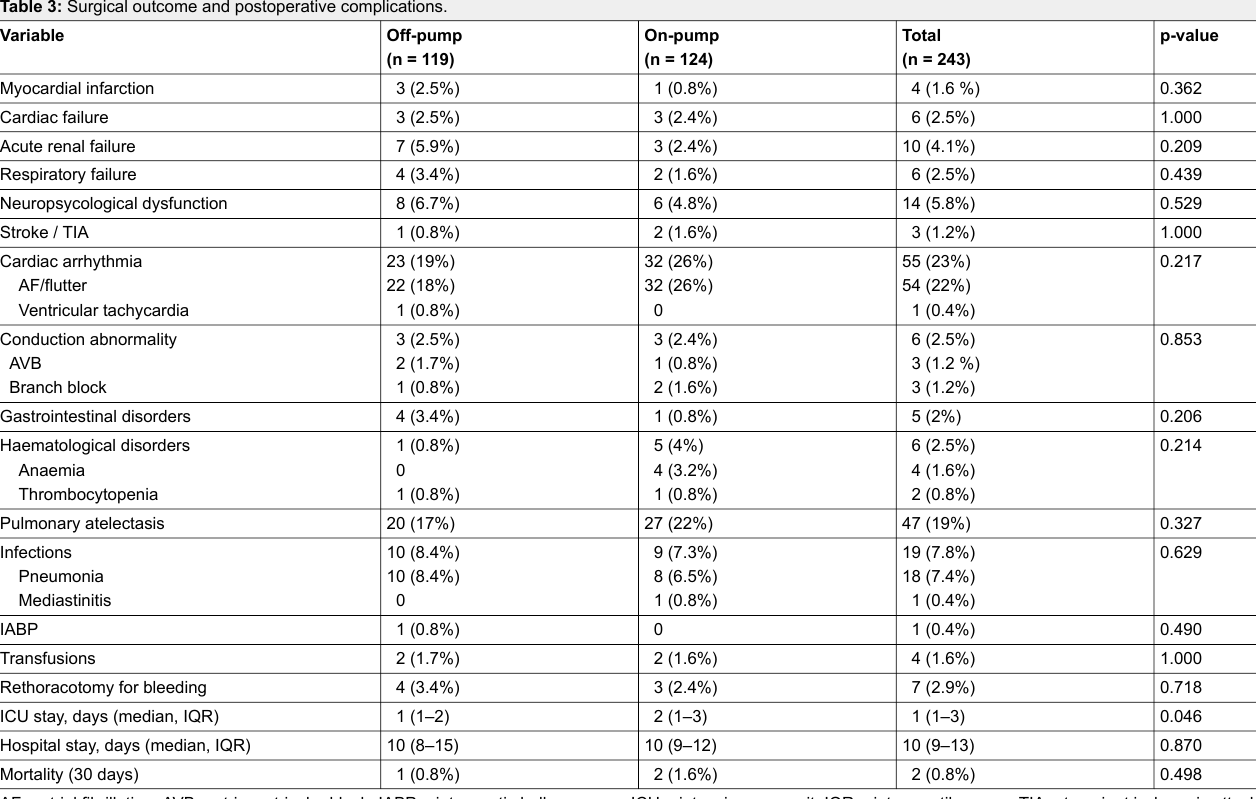
Table 3: Surgical outcome and postoperative complications.